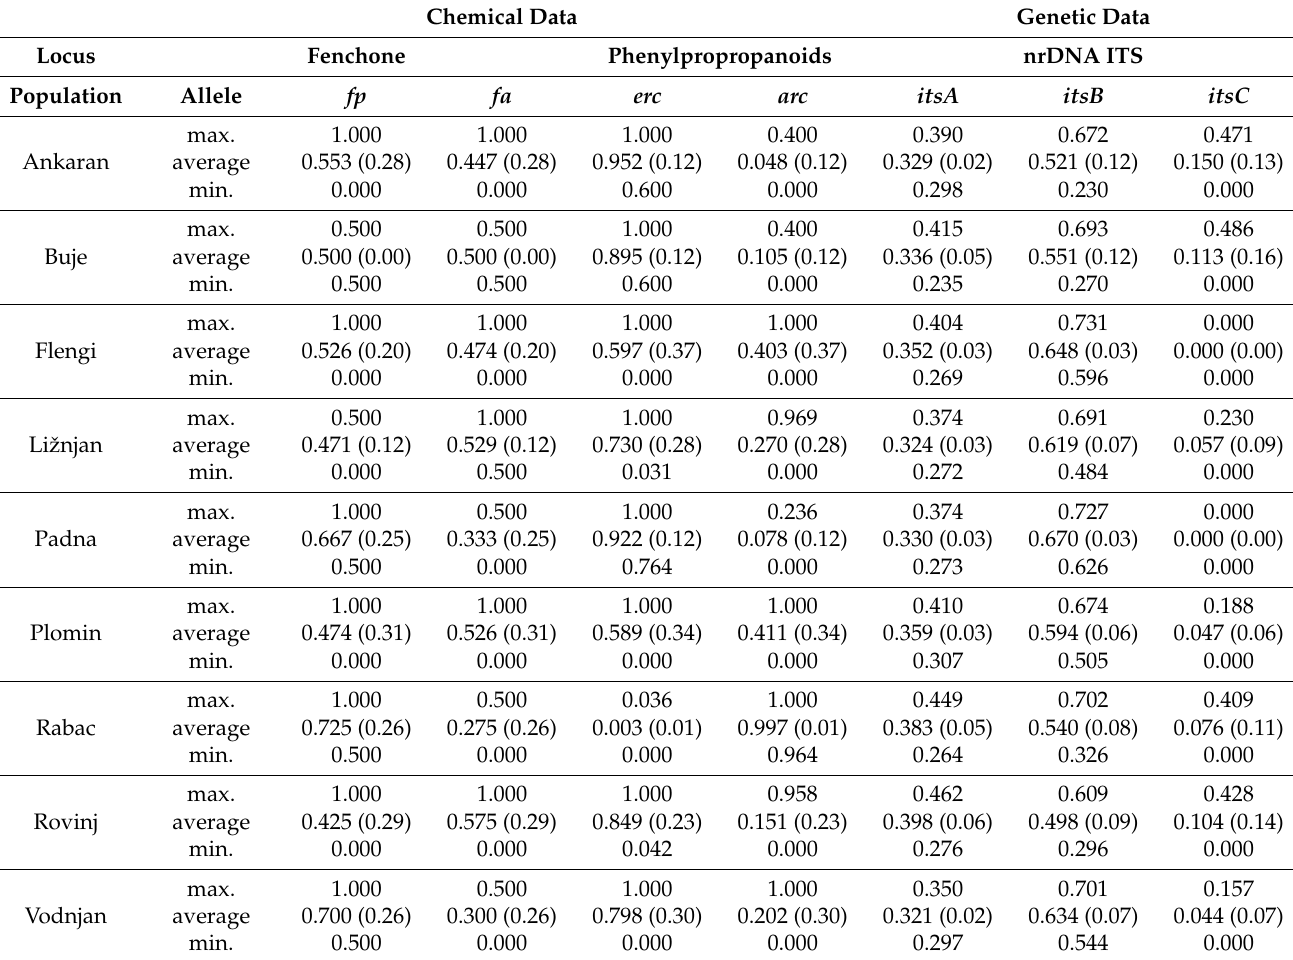
Table 1. Maximum, arithmetic average and minimum values for obtained chemical and genetic data from fennel populations in study represented as putative allele frequencies. Data in parentheses are standard deviation